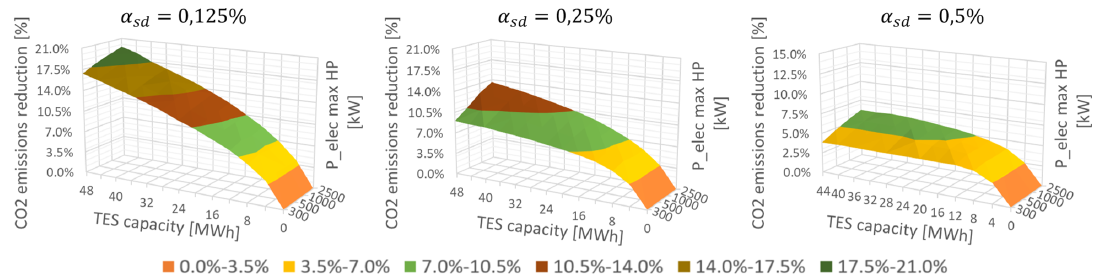
Figure 14. CO 2 emissions reduction according to the design of the heat pump and energy storage